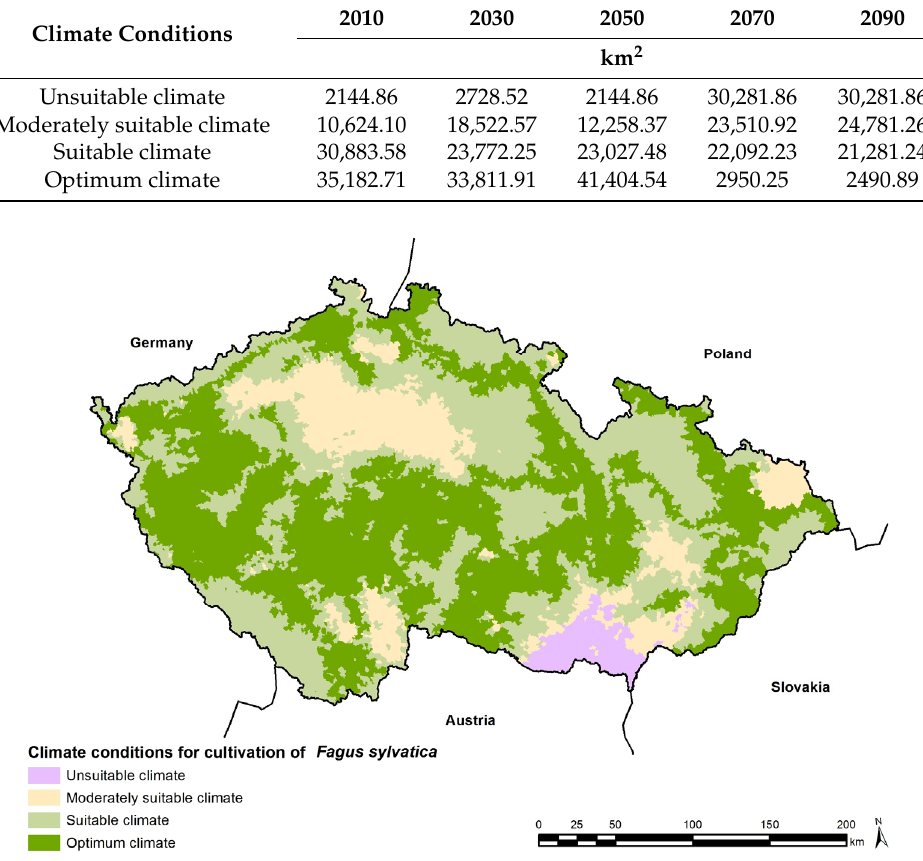
Figure 2. Present status (2010) of climate conditions for European beech in the Czech Republic.